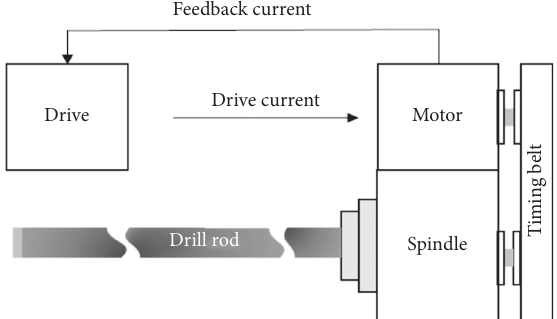
Figure 1: The overall structure of the spindle transmission system of the CNC machine